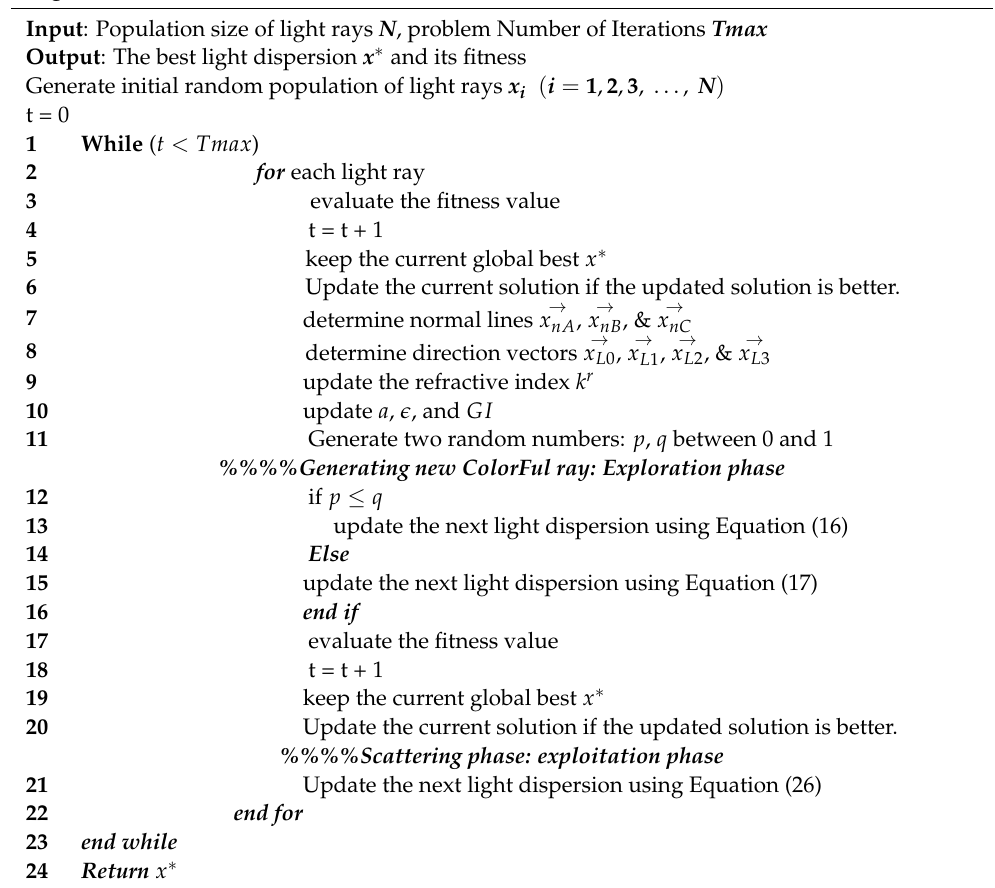
Algorithm 1: LSO Pseudo-Code